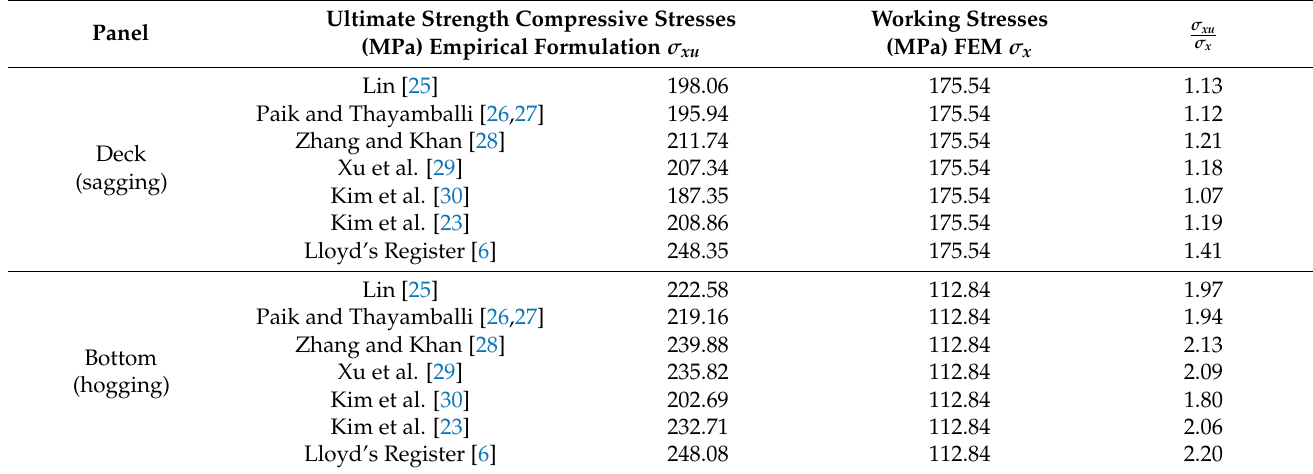
Table 8. Summary of ultimate strength and working stresses of stiffened panels of barge.